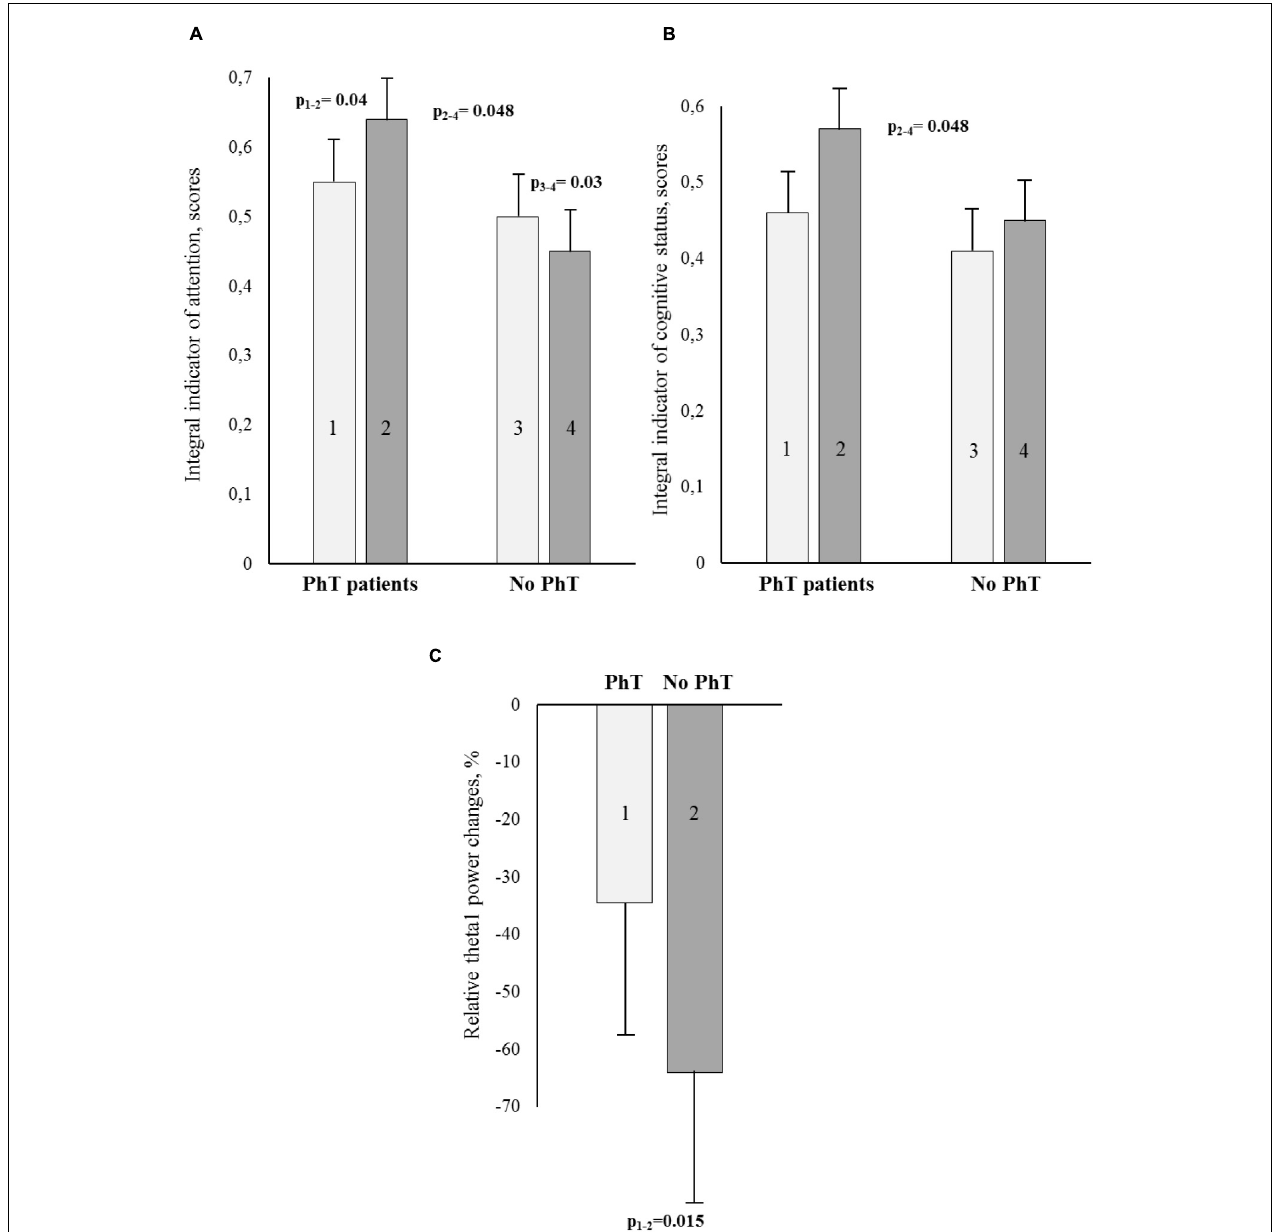
FIGURE 2 | Cognitive and electroencephalographic (EEG) indicators [ A – attention; B – integral indicator of cognitive status; C – relative theta1 power changes (%)] for the PhT (physical training) group and the group who did not undergo PhT before and after coronary artery bypass grafting (CABG). (A,B) – Light bars indicate preoperative values, dark bars – postoperative ones. Vertical bars denote standard errors